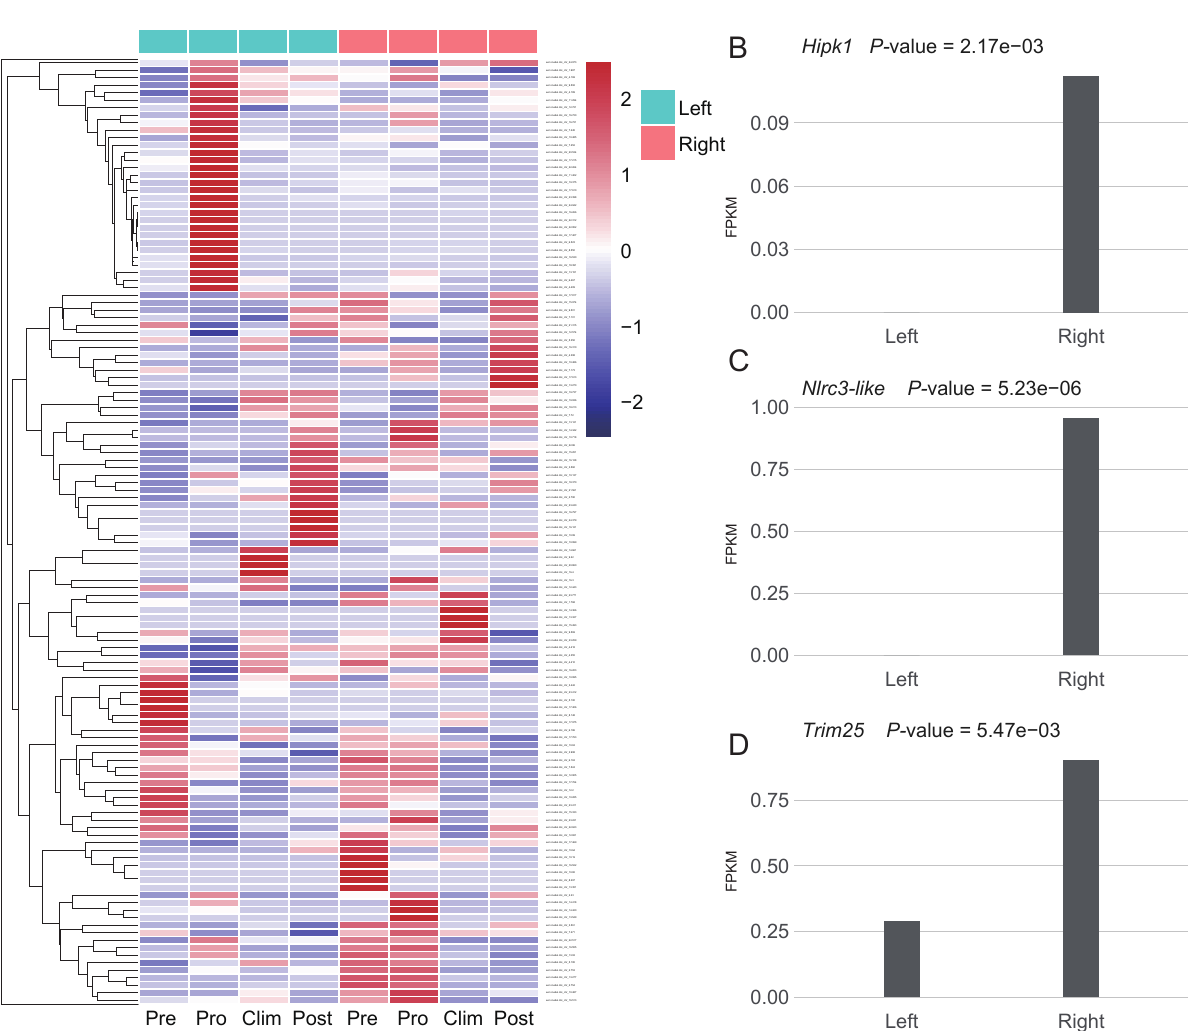
Figure 3. New genes expressed in Japanese flounder. ( A ) Heatmap of expression of 200 Pleuronectoidei-specific new genes which are present in Japanese flounder in left and right side muscle at different development stages, Pre, pre-metamorphic larva; Pro, pro-metamorphic larva; Clim, metamorphic climax larva; Post, post-metamorphic larva. Genes were clustered by hclust [44]. ( B – D ) Expression level and p -value of genes Hipk1 , Nlrc3-like and Trim25 at the pro-metamorphic larva of